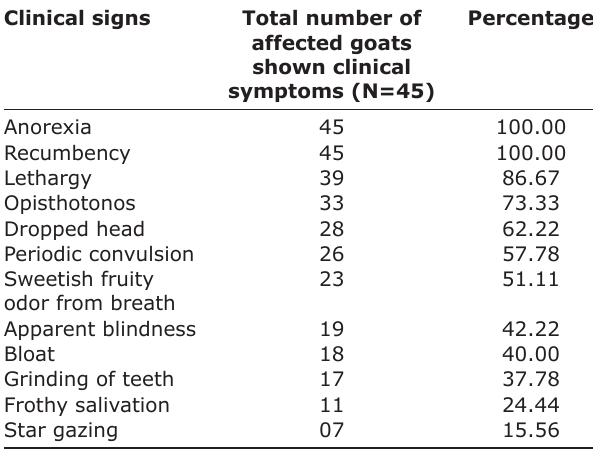
Table-2: Clinical variant recorded from pregnancy toxemic goats.